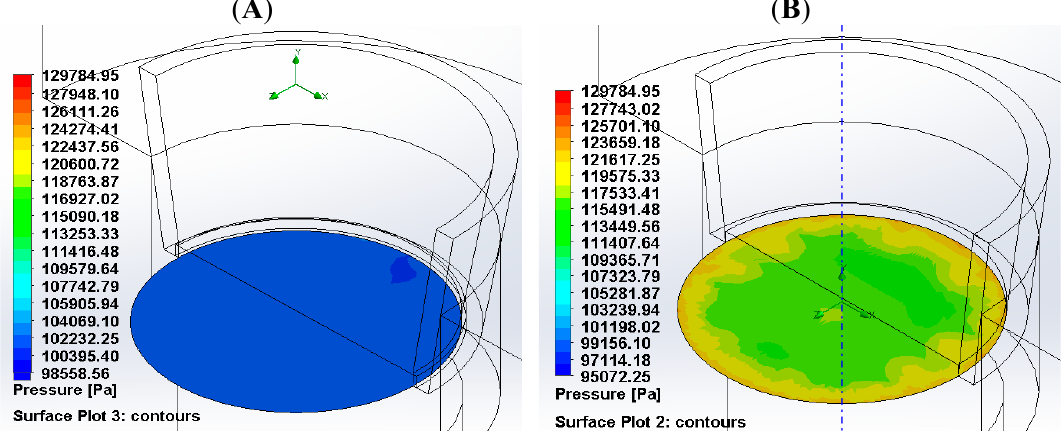
Figure 9. ( A ) A surface plot depicting the absolute pressure occurring radially across the transwell insert membrane having cell suspension permeability; ( B ) A surface plot depicting the absolute pressure occurring radially across the transwell insert membrane having articular cartilage